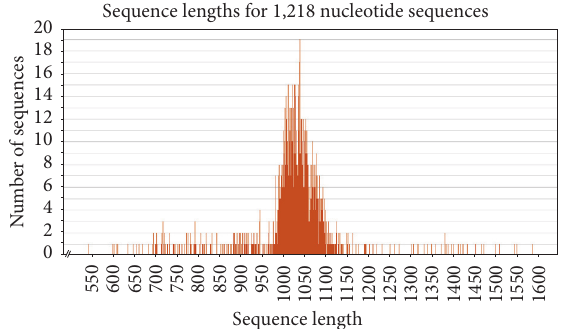
Figure 3: The length of prenatal ESTs.